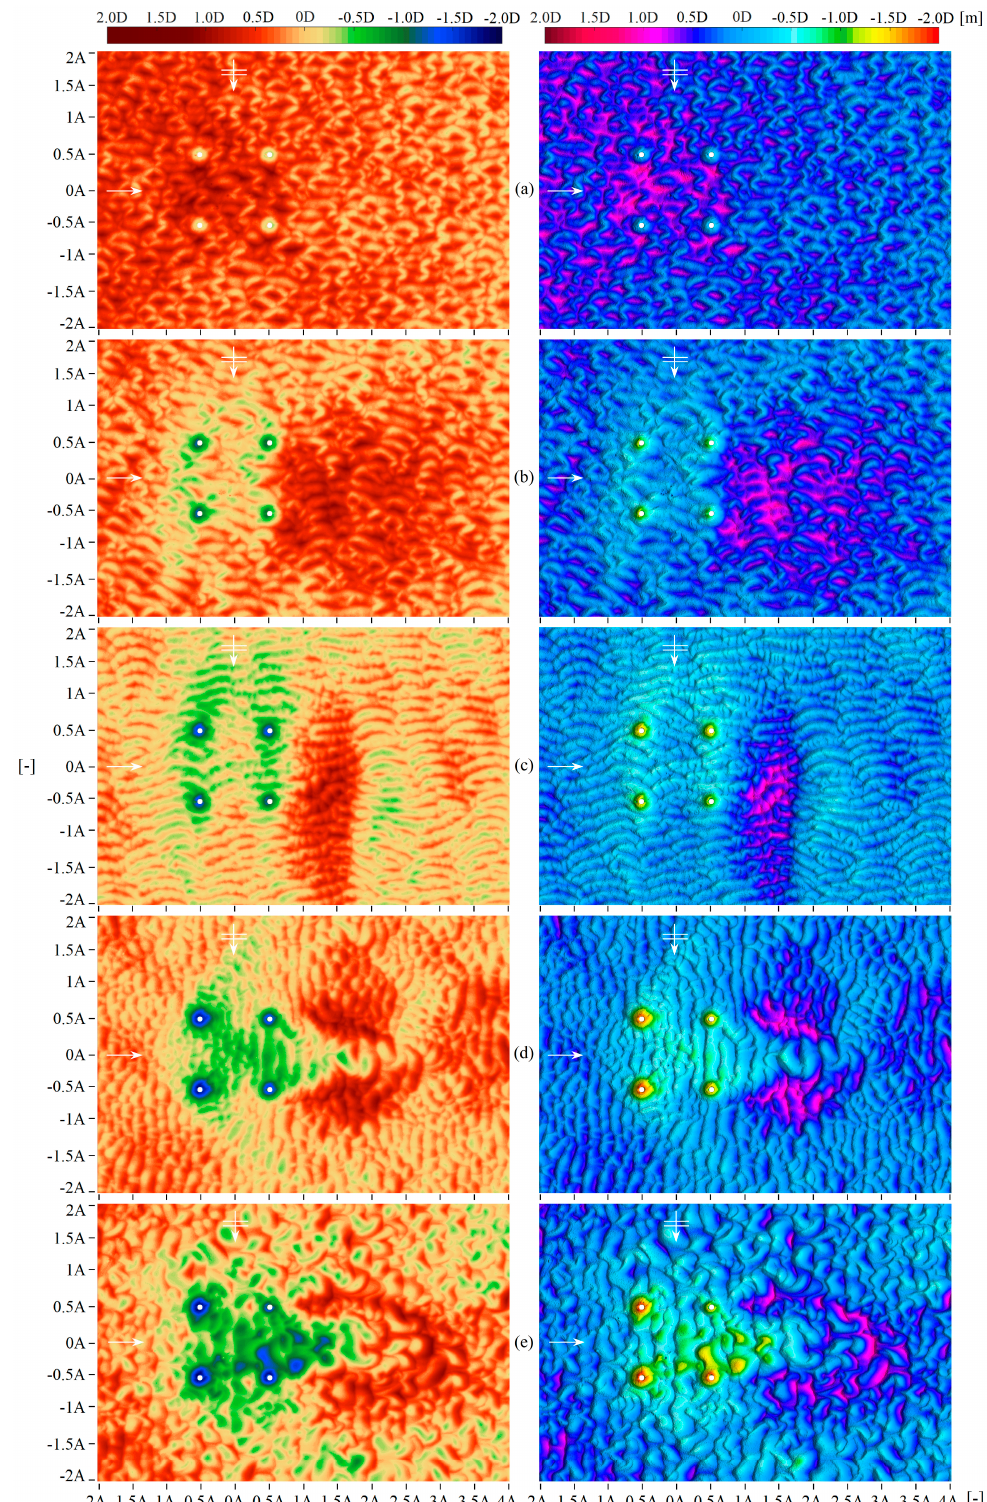
Figure 5. Bed topography measured after test 1–5 ( a–e ), top view on erosion and deposition around the jacket structure, current is coming from left to right, waves are propagating in 90° to the current, x and y distances given times the structure footprint length of 0.55 m, 1 A = 0.55 m/0.55 m [-]; ( left ) optimized illustration to differ between global (green) and local (blue) erosion depths as well as deposition (red); ( right ) HSV colourmap to differentiate between different elevations.